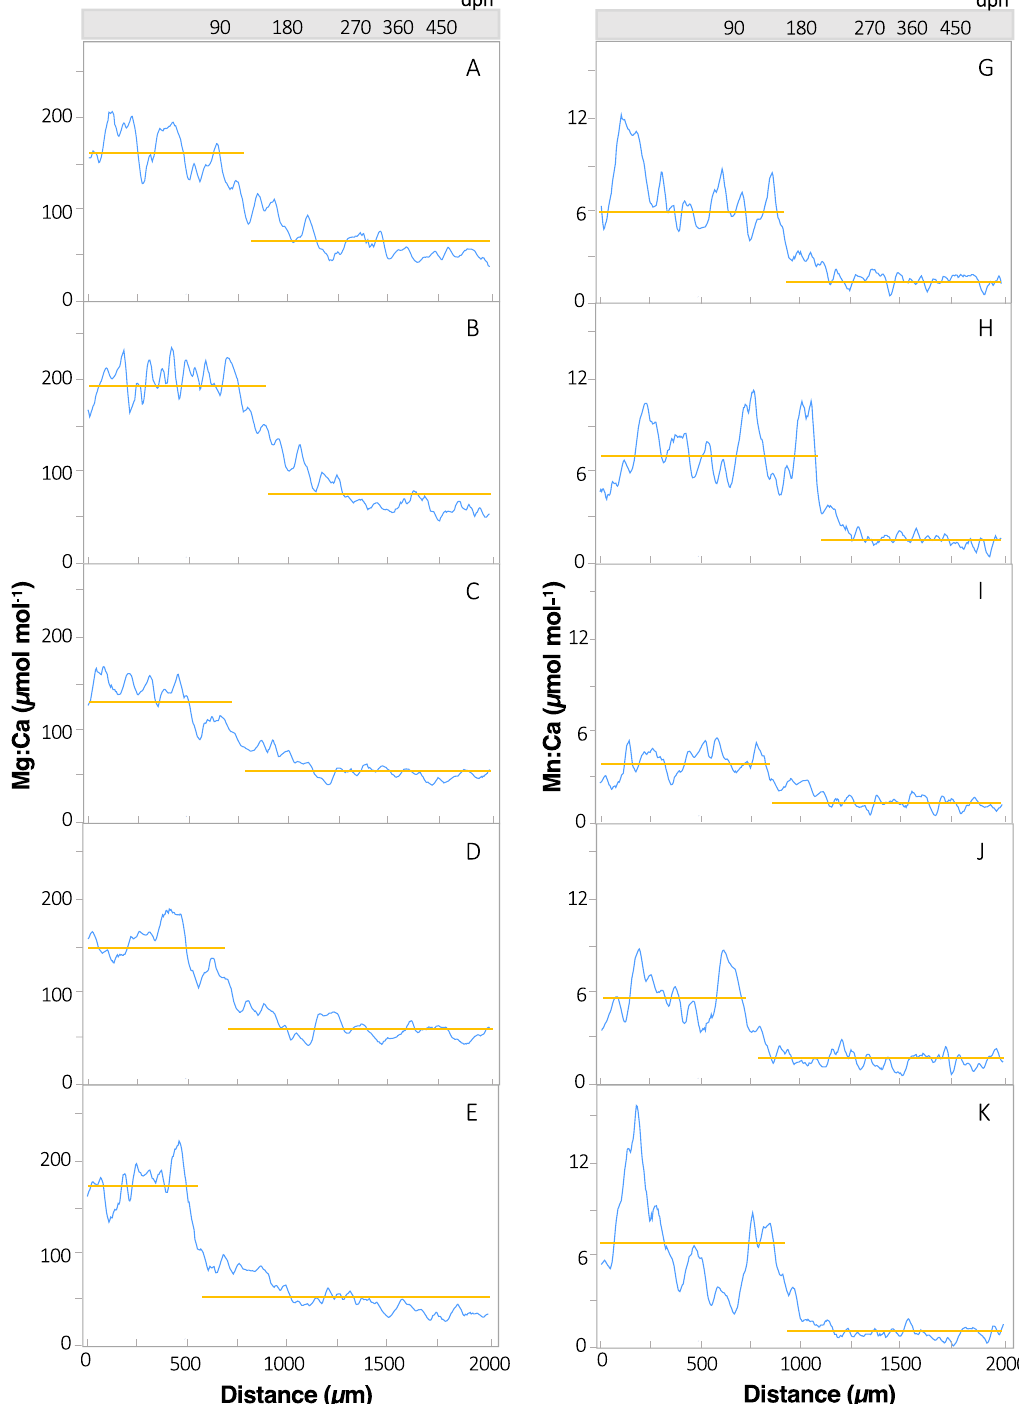
Figure 4. Otolith Mg:Ca (left, panels A – E ) and otolith Mn:Ca (right, panels G – K ) profiles for five individual Pacific bluefin tuna. Identification numbers from top to bottom: 103 ( A , G ), 210 ( B , H ), 221 ( C , I ), 271 ( D , J ), 463 ( E , K ); Table S2. Blue lines represent 7-point moving average and the location of geochemical changepoints along the laser path from otolith core to 2000 µm are shown as breaks in the horizontal lines (gold). Estimates of age isolines corresponding to distance along the laser path are also